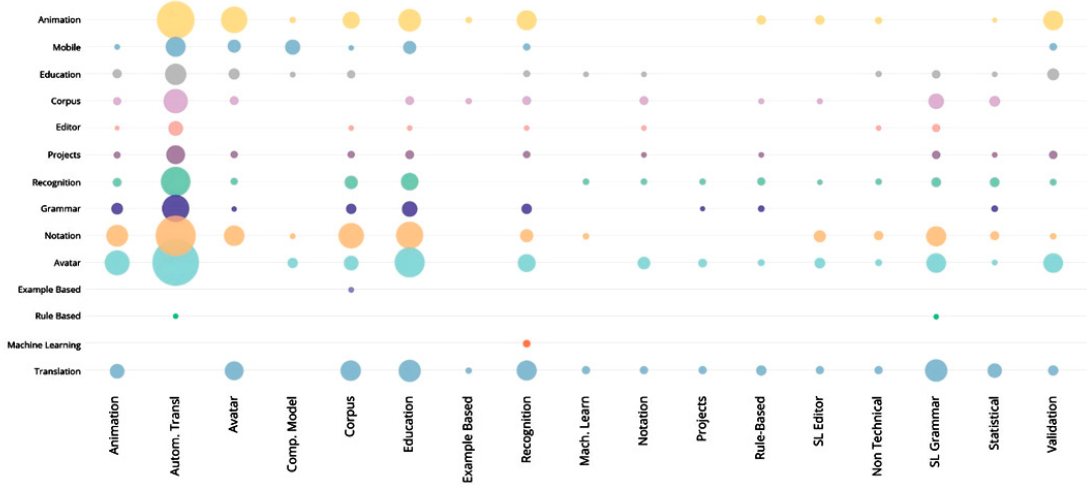
Figure 5. Topics covered (classification-subclassification bubble chart).